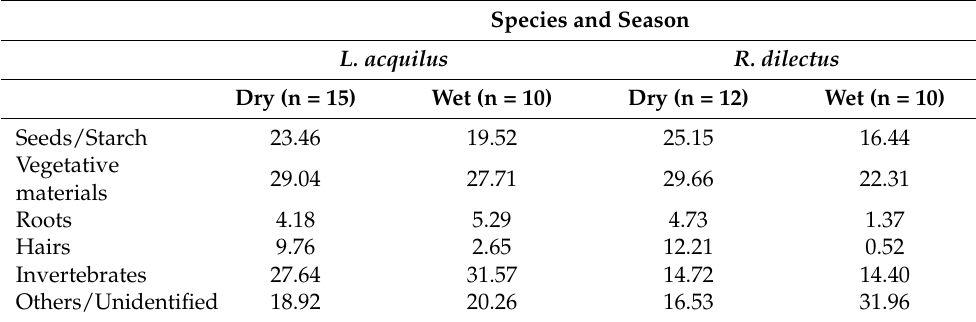
Table 3. Relative importance in percentage (%) and sample size (n) of Lophuromys acquilus and Rhabdomys dilectus in fallow land across the 2 seasons.